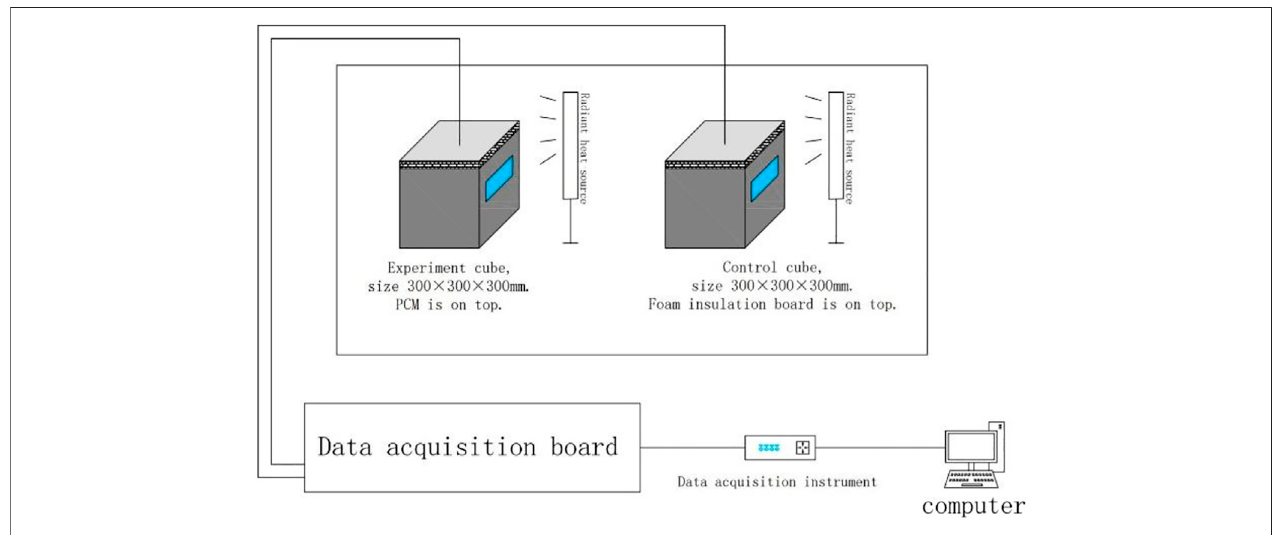
FIGURE 8 | Schematic diagram of the test rig.